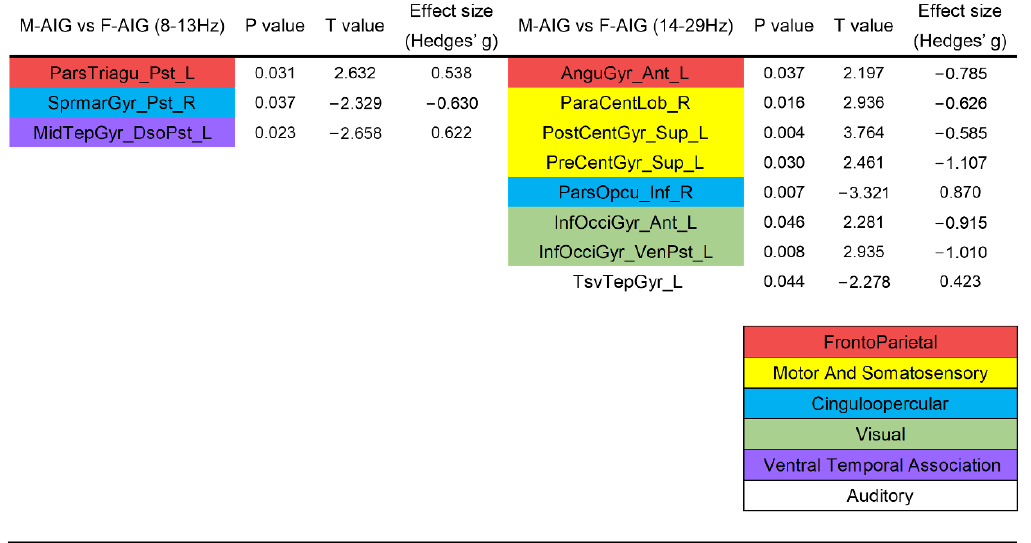
Figure 6. Comparison of ROIs’ activation between M-AIG and F-AIG in alpha and beta bands. M-AIG: male action observation-induced group; F-AIG: female action observation-induced group; L: left, R: right; p < 0.05, FDR corrected (for the full name of ROIs see Supplementary Table S1). Colors for functional modules: red: frontoparietal system; yellow: motor and somatosensory system; blue: cinguloopercular system; green: visual system; purple: ventral temporal association; white: auditory system.